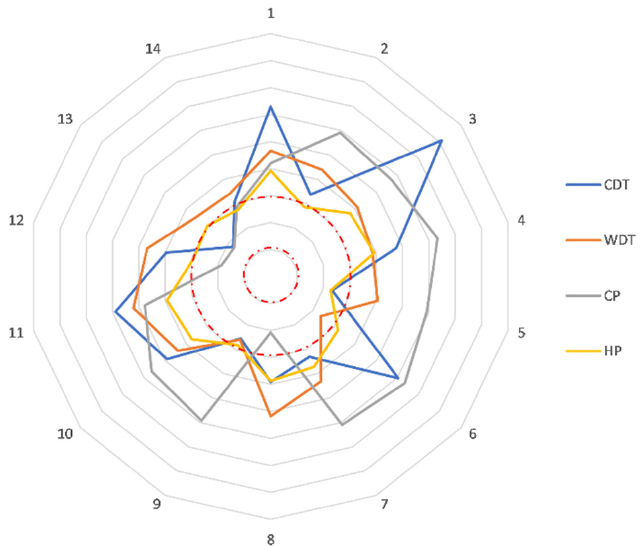
Figure 1. Radar representation of thermal QST at leg site. In the figure was represented the z-score value of all thermal modalities for each patient (each radius of the wheel). The red dotted circle lines represent the abnormal z-score value cut-off (the outer line is the +2 z-score, and the inner one is the − 2 z-score).